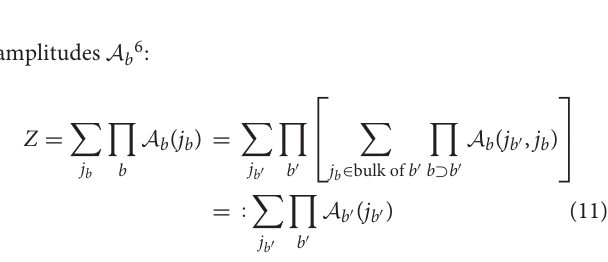
amplitudes A b 6